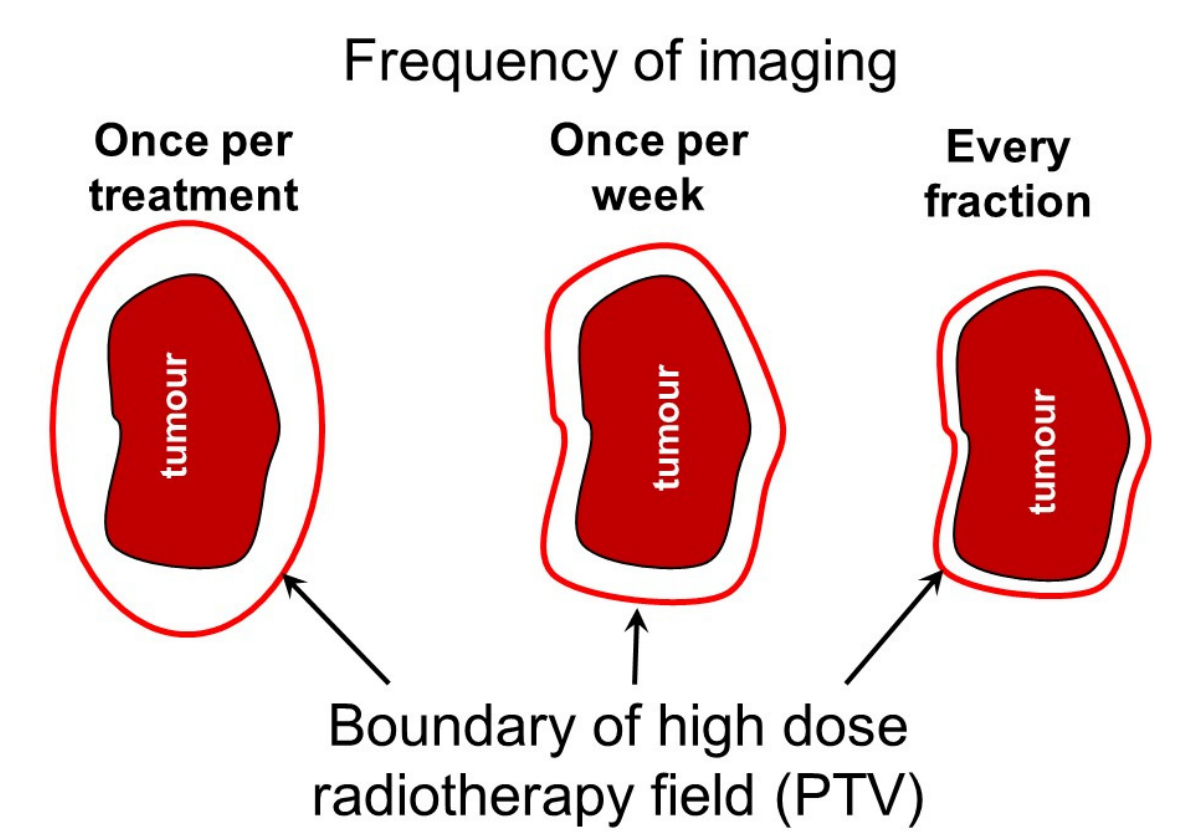
Figure 1. Schematic diagram illustrating the relationship between the planning target volume (PTV) around a tumour and the frequency of imaging during radiotherapy treatments. High-dose margins around tumour targets are used to account for uncertainty in target location and more frequent imaging allows margins to be reduced to protect normal tissue. There is a balance between reducing the width of these high-dose margins around the target and lowering the dose to surrounding normal tissues from more frequent imaging.